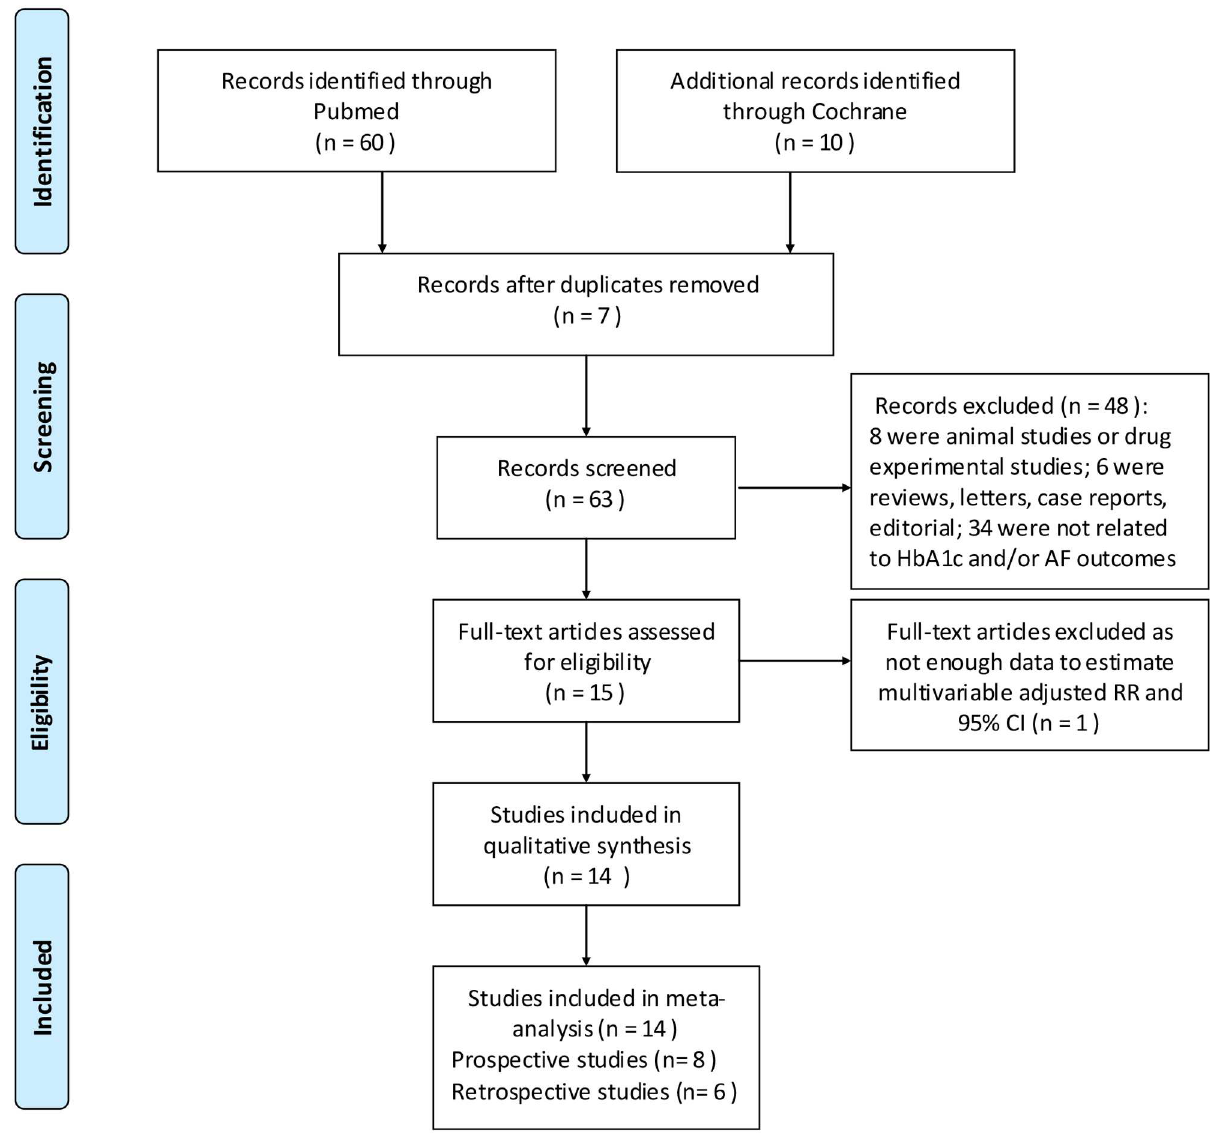
Fig 1. Flow chart of selection of studies for inclusion in meta-analysis. From : Moher D, LiberatiA, Tetzlaff J, Altman DG, The PRISMA Group (2009). P referred R eporting I tems for S ystematic Reviews and M eta- A nalyses: The PRISMA Statement. PLoS Med 6(6): e1000097.